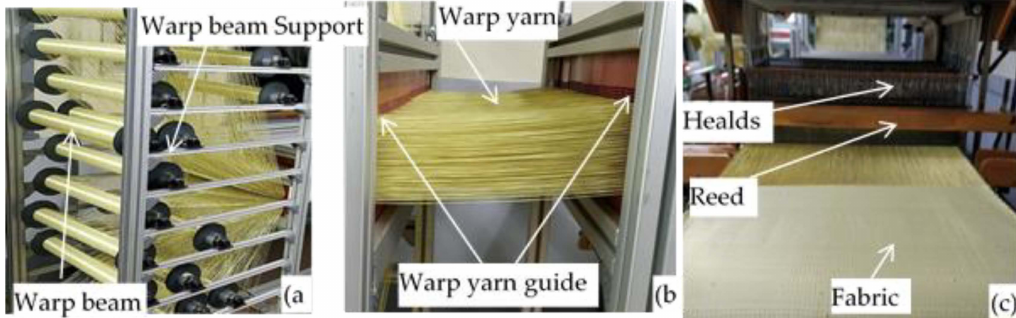
Figure 1. Manufacturing of intended 3D warp interlock fabrics using ARM semi-automatic looms (located in ENSAIT-GEMTEX laboratory); ( a ) adapted warp beam creel and beam arrangement; ( b ) Warp yarn guiding system and ( c ) weaving machine head and produced